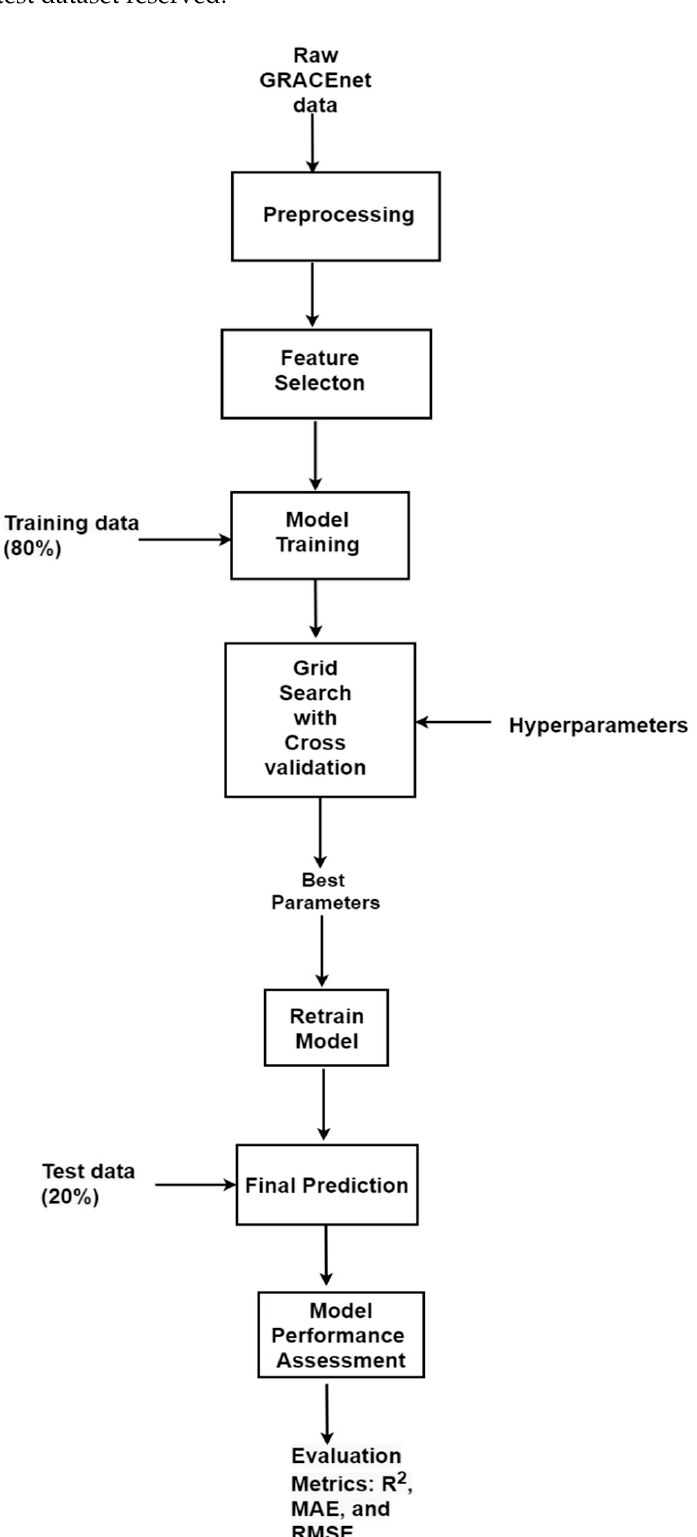
Figure 1. Summary of steps for developing models to predict CO 2 flux using machine learning al- gorithms.